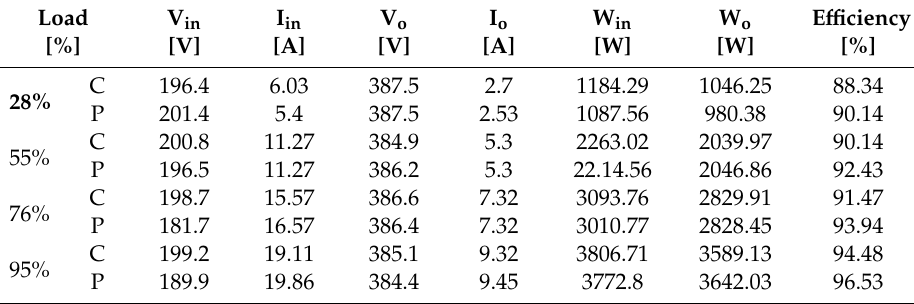
Table 2. E ffi ciency comparison of conventional and proposed